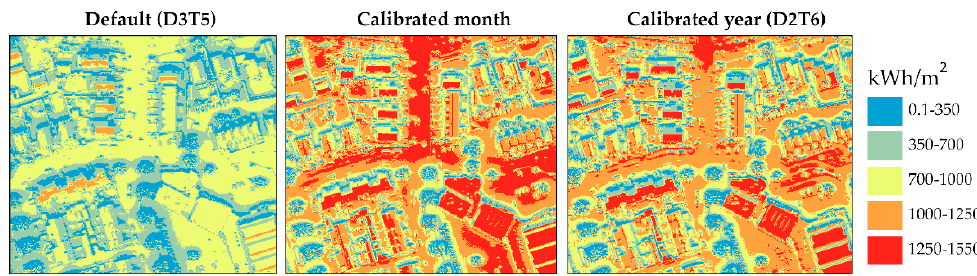
Figure 8. Modelled irradiation for a geographic area with default model (D3T5) and calibrated models.